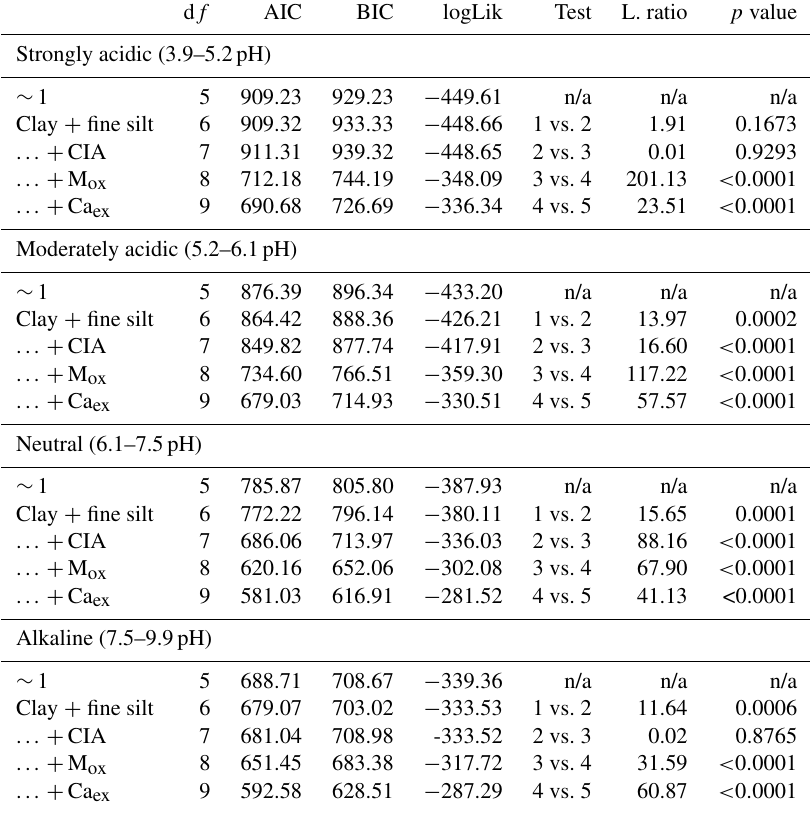
Table B6. ANOVA summary for linear mixed-effects grouped by pH H n alkaline = 400). Fixed effects were added using a step-wise method. The first entry ( ∼ 1) refers to the constant null model,